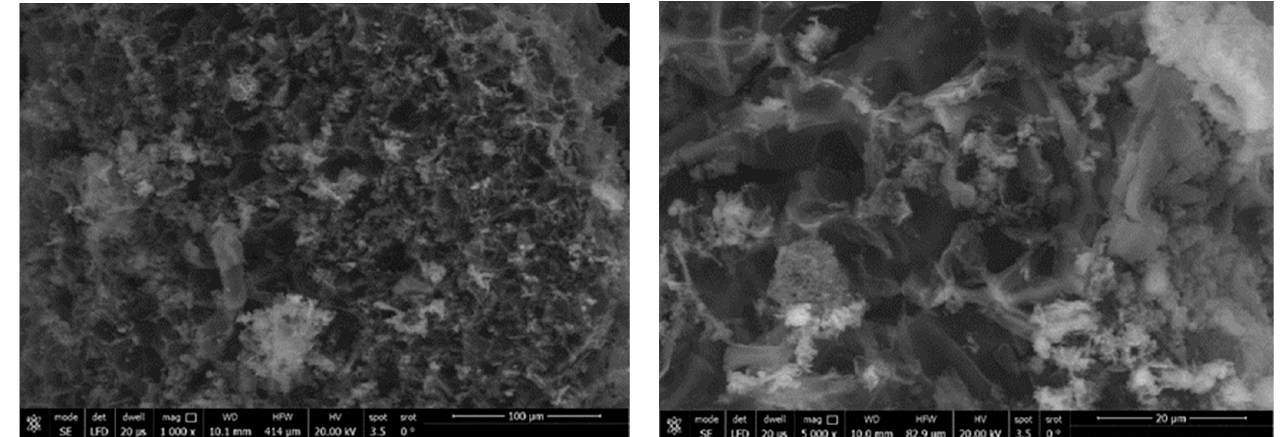
Figure 4. The hierarchical porous structure of activated carbons generated from WTLs.